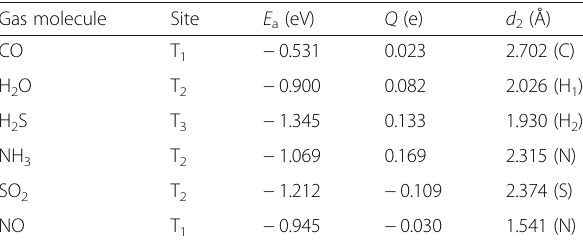
Table 1 Calculated E a , Q , and d 2 of small gas molecules adsorbed on PG Gas